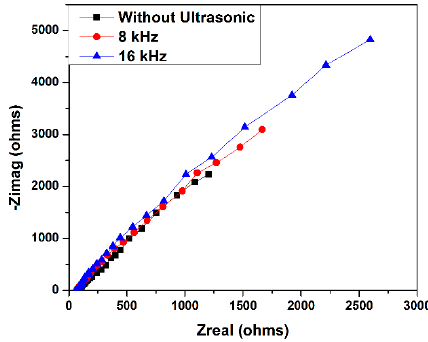
Figure 5. Nyquist plots for TiN coated samples after ultrasonic treated at 8 kHz and 16 kHz. Metals 2018 , 8 , x FOR PEER REVIEW